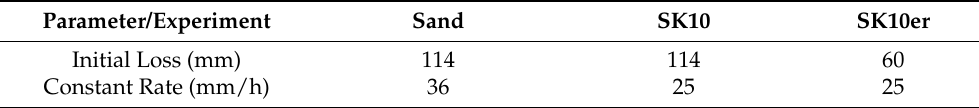
Table 4. Initial and constant method initial parameters that were used for the rainfall–runoff simulations. Parameter/Experiment